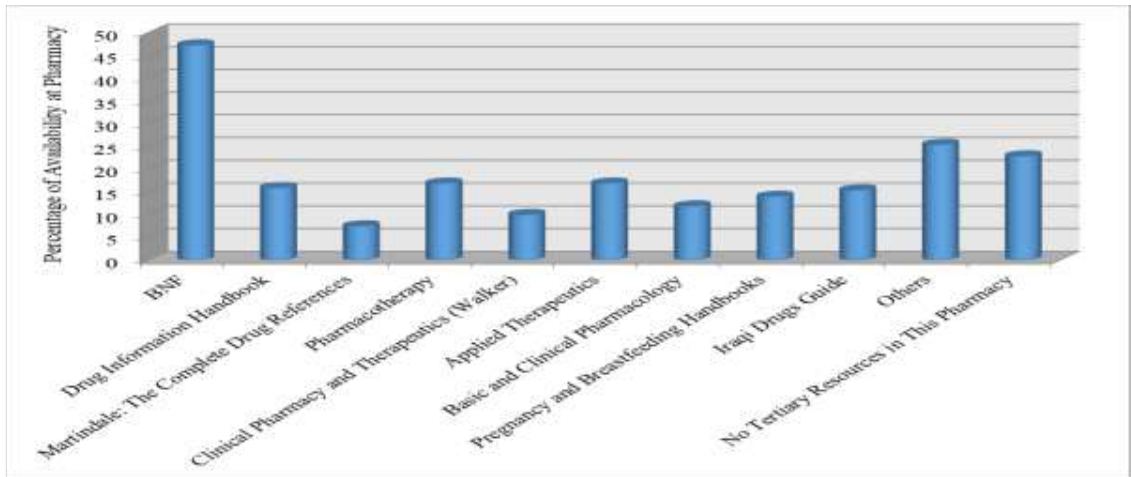
Figure 1. Tertiary textbooks available in the pharmacy where the participants currently in (a hard copy or soft copy).